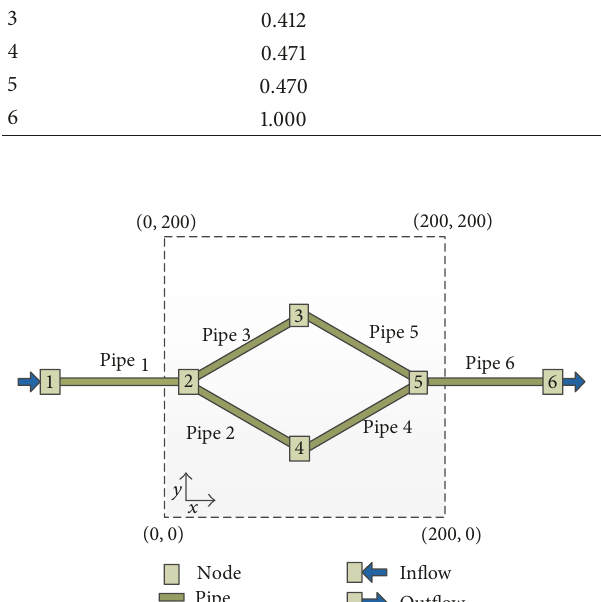
Figure 9: Schematic diagrams of vertical linking